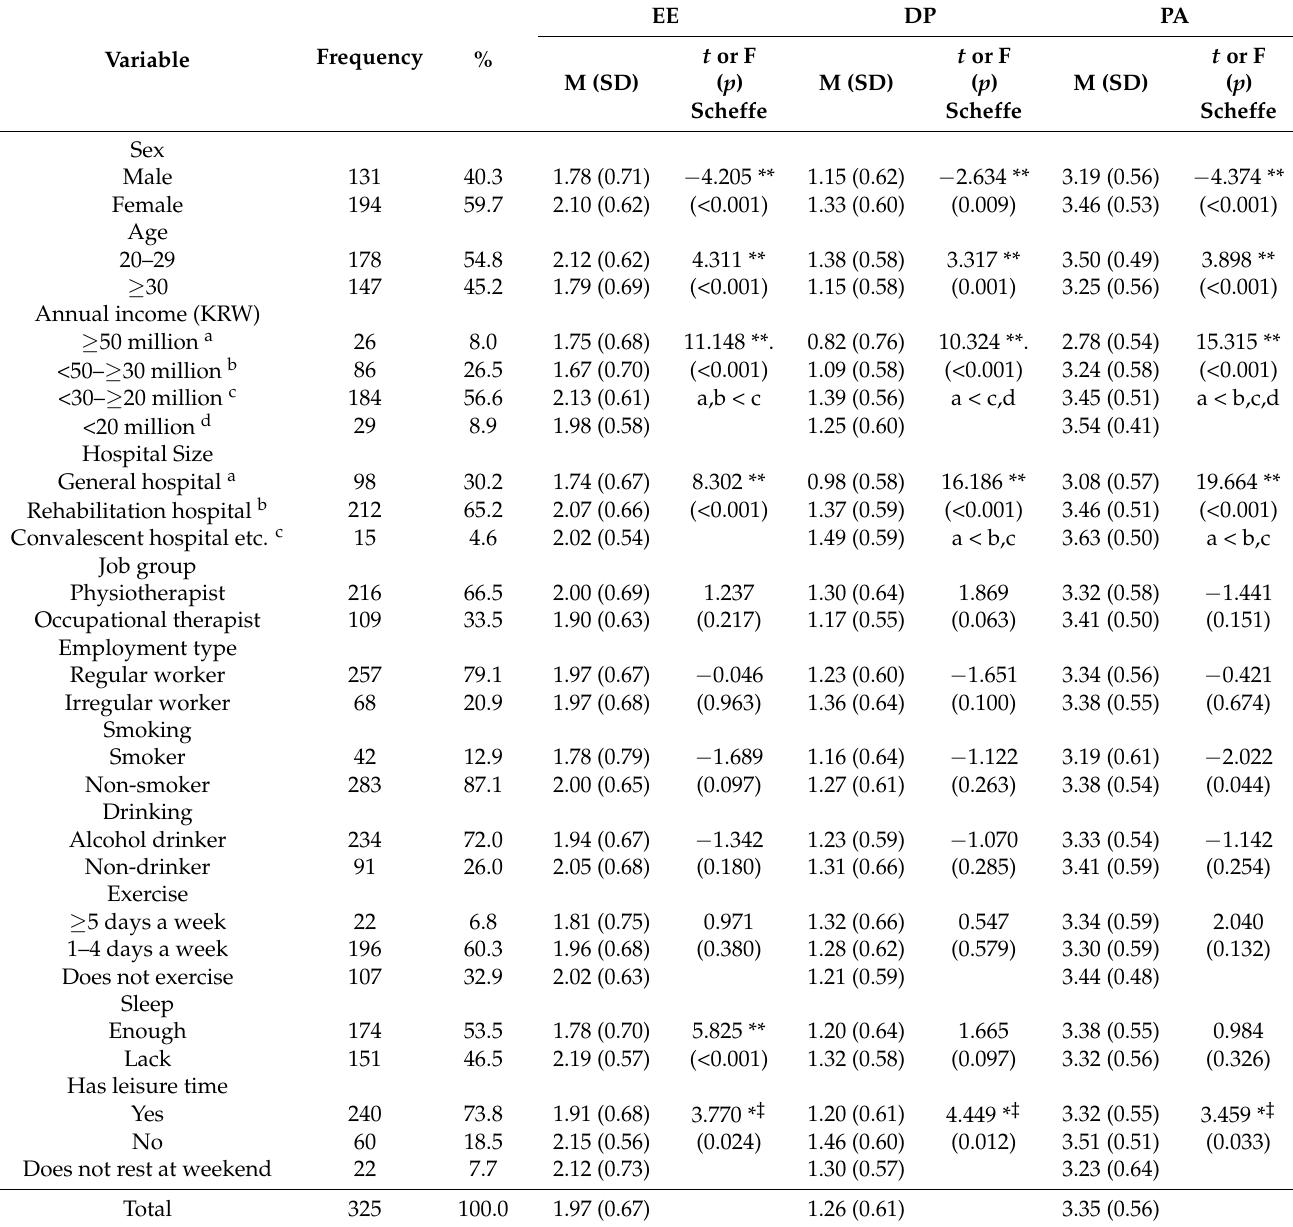
Table 2. Burnout indices by sociodemographic characteristics of rehabilitation